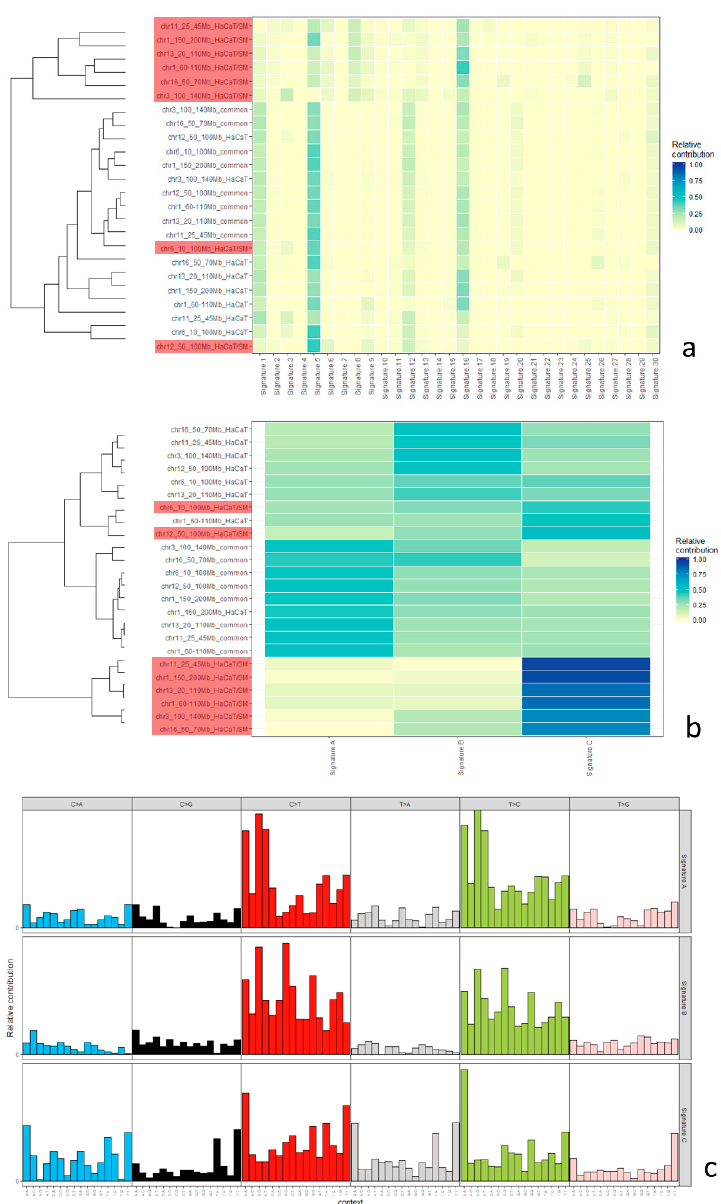
Figure 7. Mutational signatures identified in HaCaT/SM-specific SNV (next page). ( a ) Unsupervised hierarchical clustering based on the relative contribution of 30 previously published mutational signatures. The numbering of signatures refers to Mutation Signatures v2—COSMIC. Names given to the left of each heatmap indicate the chromosomal region of the respective SNV set and whether the SNV set is common or unique to HaCaT and HaCaT/SM, respectively. HaCaT/SM specific SNV sets are additionally highlighted in red. ( b ) Unsupervised hierarchical clustering based on the relative contribution of mutational signatures as extracted by non-negative matrix factorization from the 24 SNV sets representing common and unique SNVs in HaCaT and HaCaT/SM, respectively. HaCaT/SM-specific SNV sets are highlighted in red. ( c ) Relative contribution of each mutation type with reference to the pyrimidine of each basepair for the three signatures shown in ( b ). Each mutation type is shown in the trinucleotide context, i.e., in the middle of a trinucleotide with all possible combinations of neighbors to the left and right. All images were generated by means of the Mutational Patterns software package